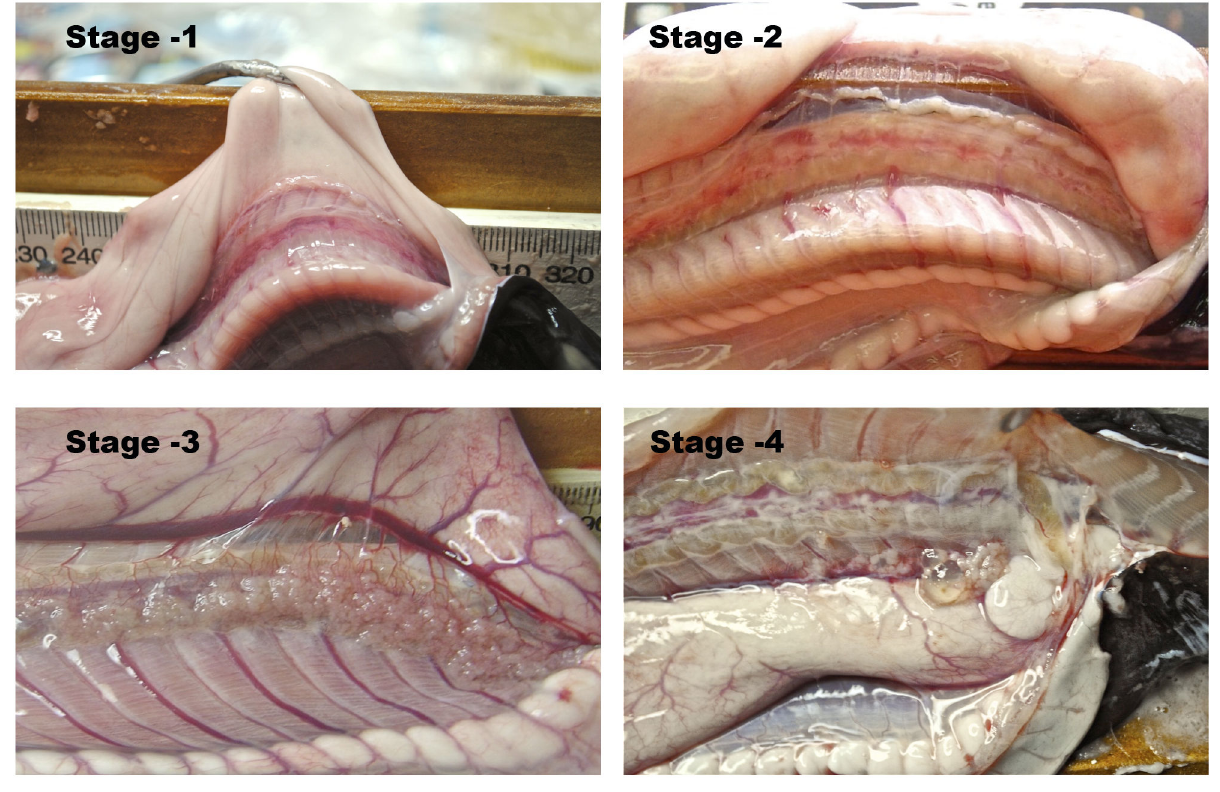
Figure 2. Stages of male sexual maturation (see Table 1).